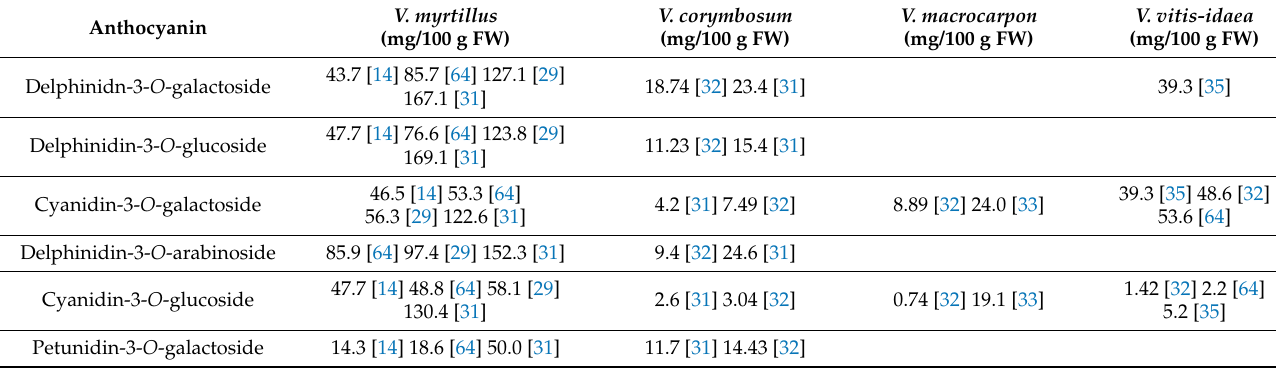
Table 2. Specific anthocyanin contents found in the fruits of Ericaceae